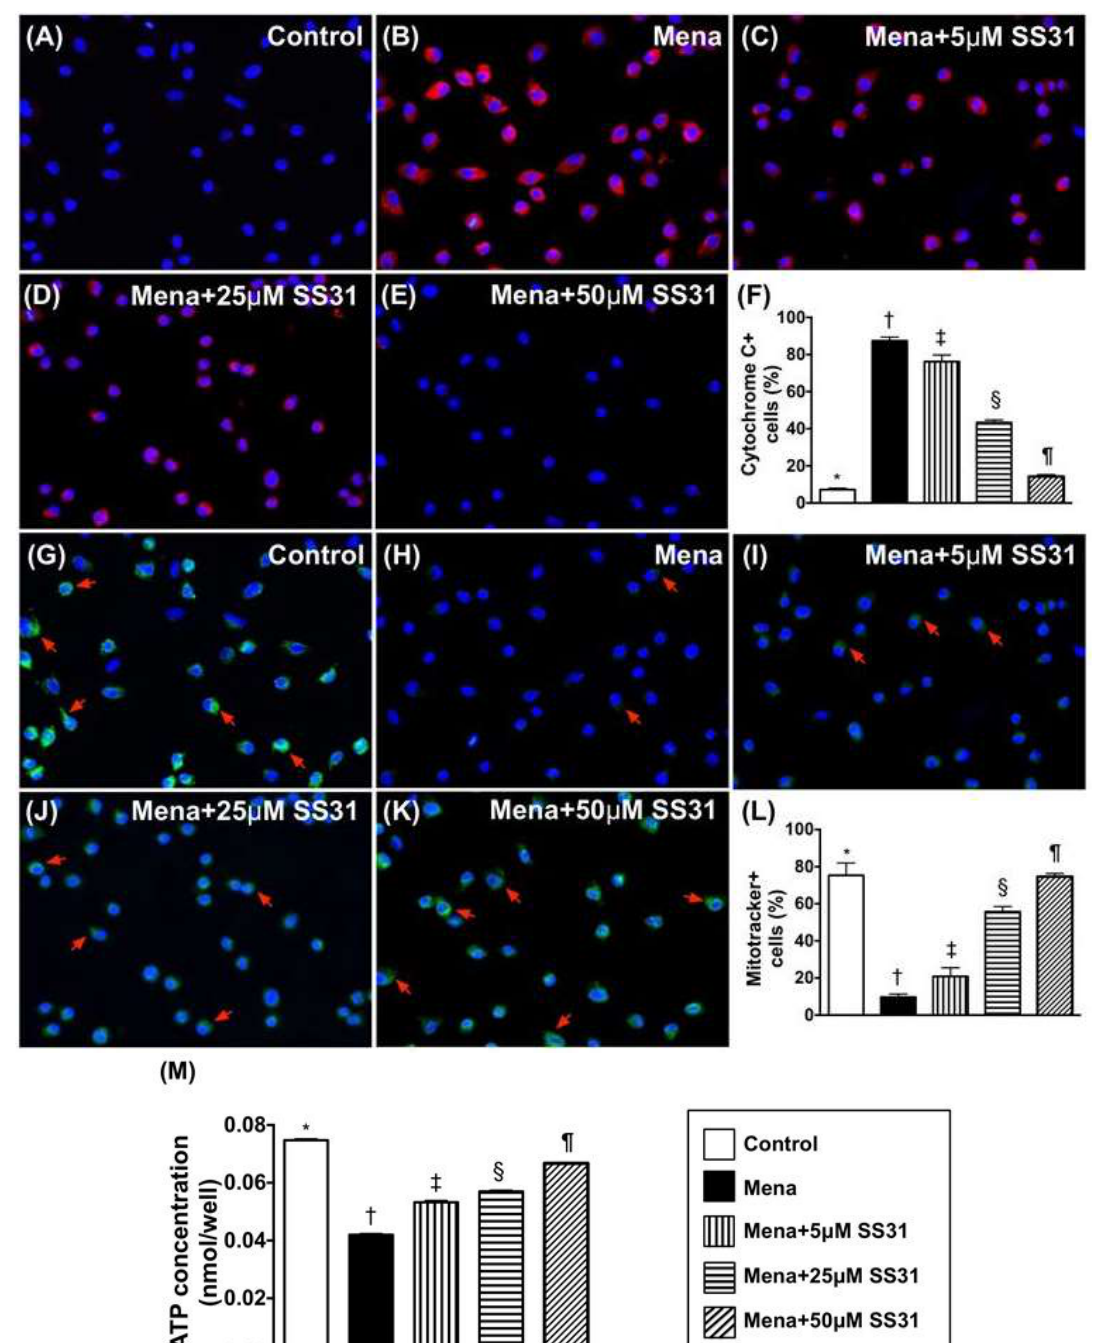
Figure 2. SS31 protects mitochondria from oxidative damage. ( A – E ) Illustrating the IF microscopic finding (400 × ) of cytosolic cytochrome C (cyt-Cyto C) staining (red color) (i.e., an indicator of mitochondrial damage). The ultrastructural cytosolic cytochrome C in H9C2 cells was notably increased by menadione treatment when compared to the normal control that was notably preserved after SS31 treatment. Blue color indicates nuclei stained by DAPI. ( F ) The analytical result of number of cyt-Cyto C+ cells * vs. other groups with different symbols (†, ‡, §, ¶), p < 0.0001. ( G – K ) Illustrating IF microscopic finding (400 × ) of mitotracker-positively stained cells (i.e., endogenous mitochondria) (green color) (red arrows). ( L ) The analytic result of number of mitotracker+ cells * vs. other groups with different symbols (†, ‡, §, ¶), p < 0.0001. ( M ) ATP concentration (i.e., measured by ELISA kit) of H9C2 cells * vs. other groups with different symbols (†, ‡, §, ¶), p < 0.0001. All statistical analyses were performed by one-way ANOVA and was followed by a Bonferroni multiple comparison post hoc test ( n = 6 for each group). Symbols (*, †, ‡, §, ¶) indicate significance at the 0.05 level.